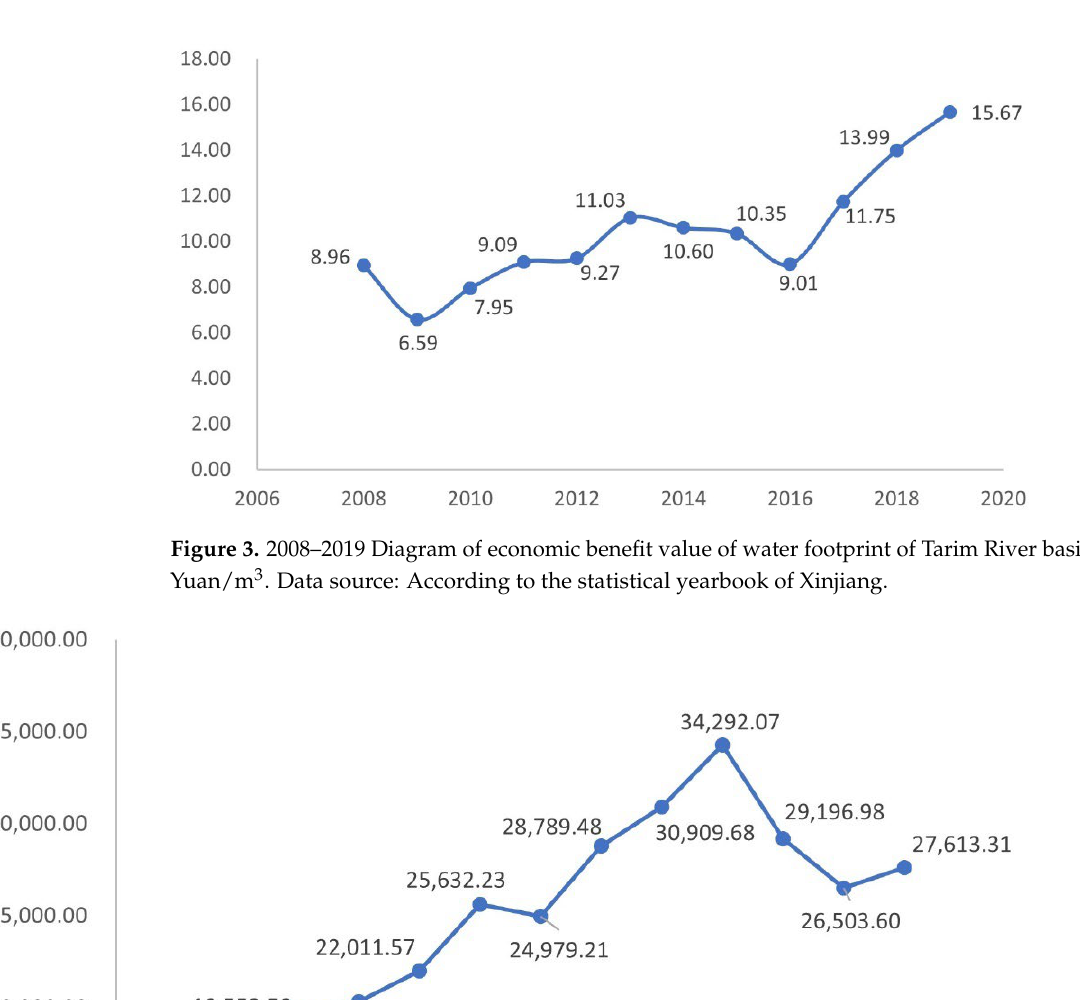
16 of 27 Figure 2. 2008–2019 Water footprint population density in Tarim River Basin. Unit: Persons/10 4 t. Data source: According to the statistical yearbook of Xinjiang. 2.